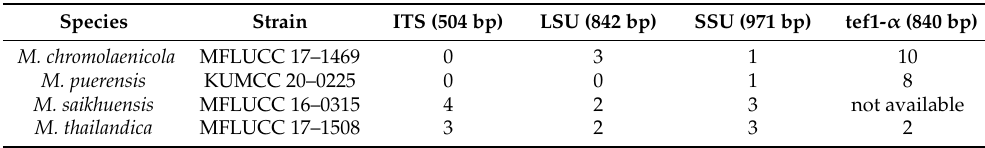
Table 4. Comparison of nucleotide differences between M. donacina (KUMCC 21–0653) and